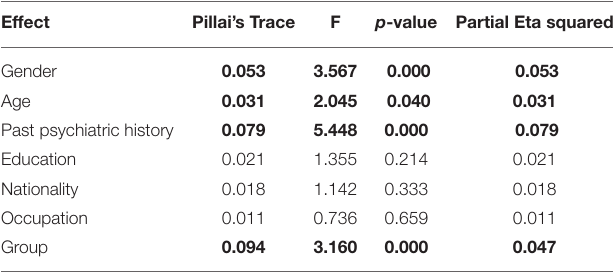
TABLE 3 | Multivariate covariance analysis comparing SF-36 scale scores between COVID-19 inpatients vs. COVID-19 infected quarantined individuals vs. controls controlling for sociodemographic and clinical